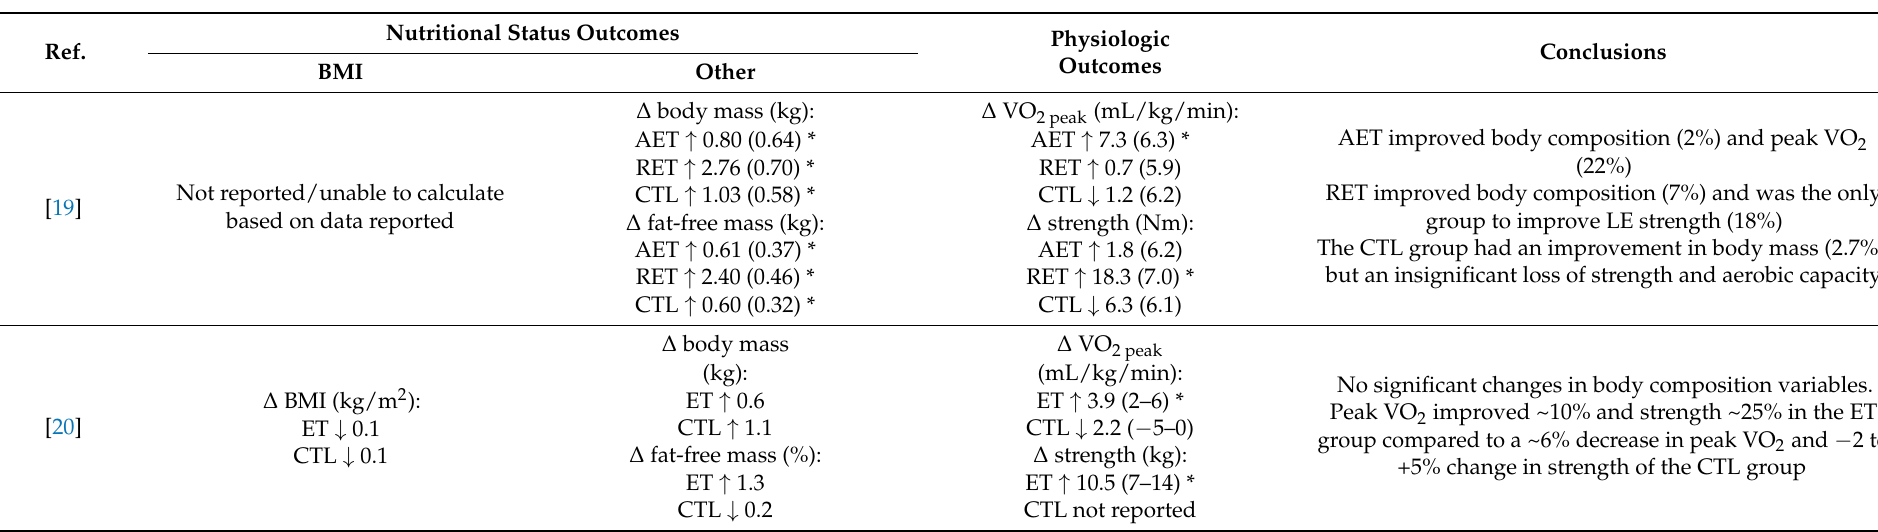
Table 4. Nutritional status and physiologic outcomes of randomized controlled trials of exercise in people with CF.